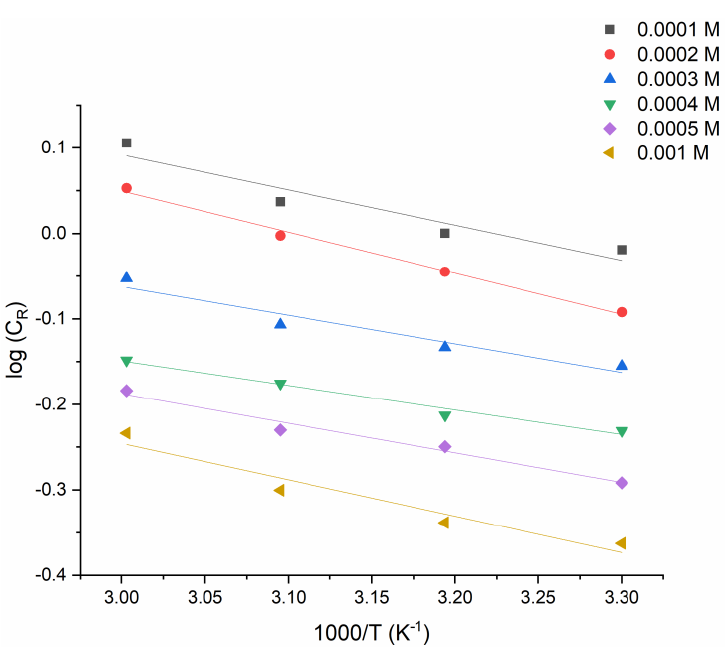
Figure 4. The log (C R ) versus 1/T graph for the various concentrations of PMBMH and different temperatures.